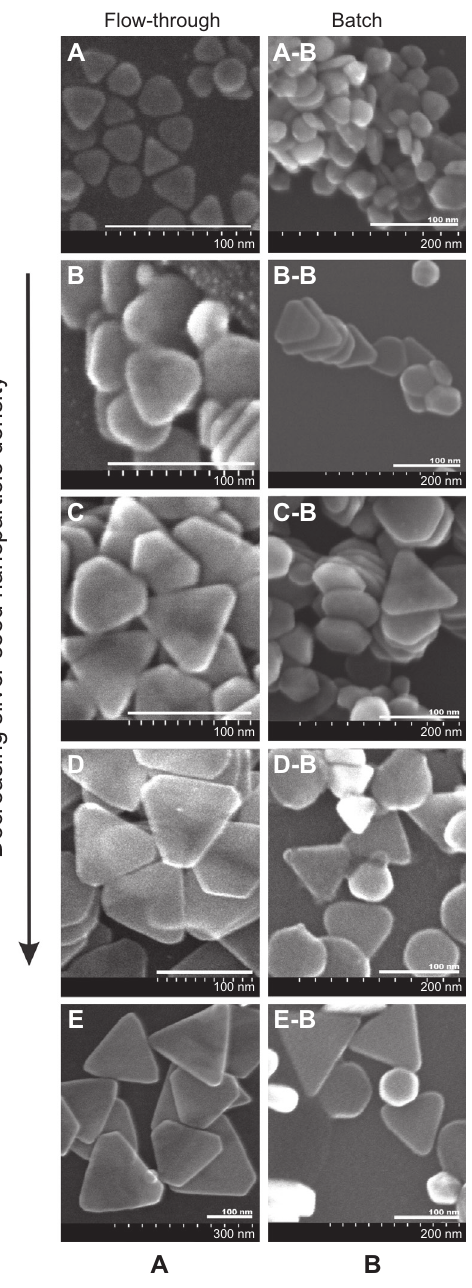
Figure 9 Comparison of SEM pictures of (A) flow-through generated and (B) batch-prepared silver